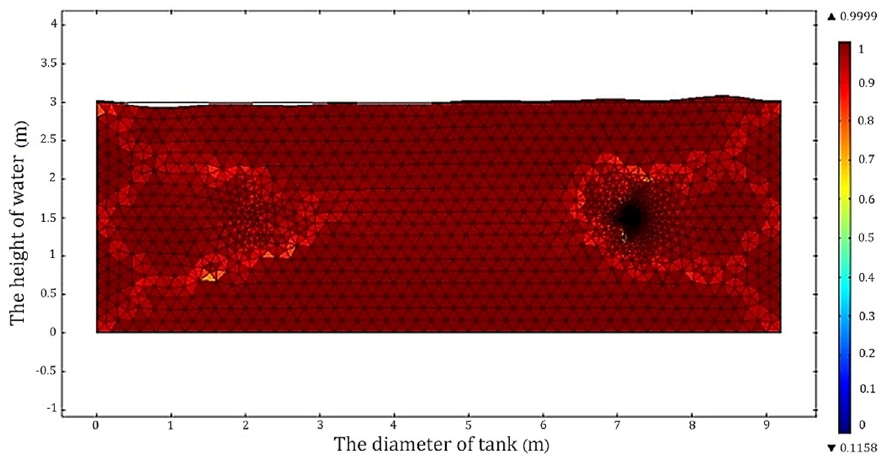
Figure 3. Moving mesh in cross-section of the